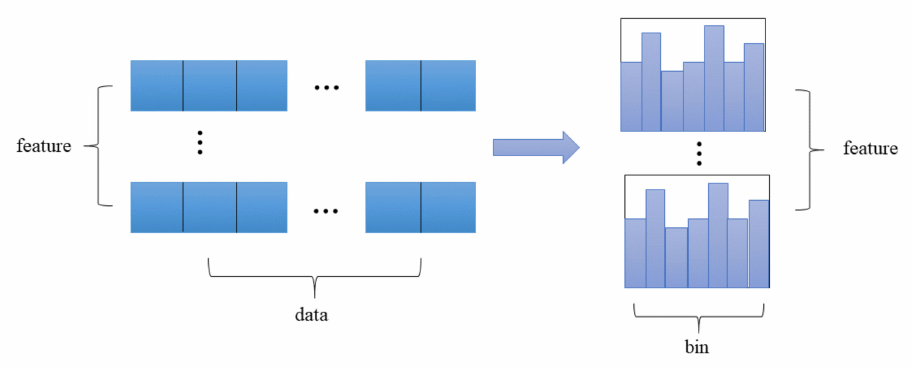
Figure 2. Histogram